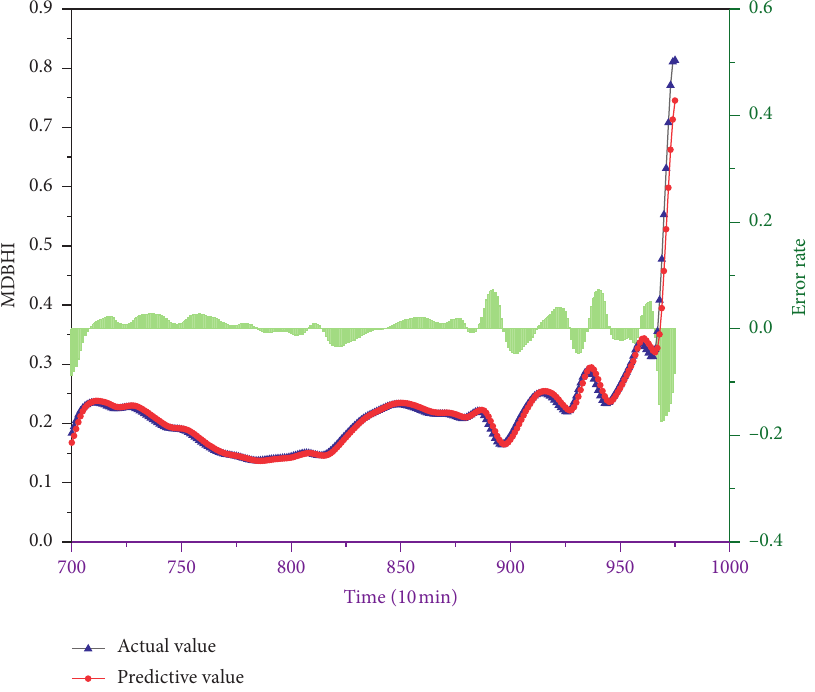
Figure 14: The prediction results and prediction error rate of the proposed